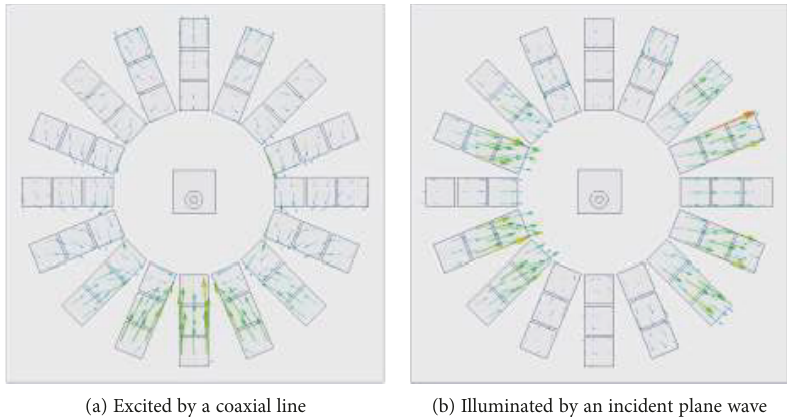
Figure 9: The surface current of the AMC patch.